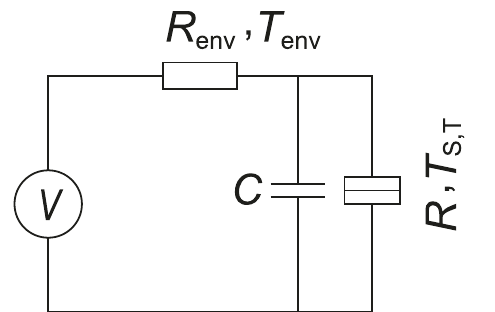
Fig. 2 Lumped element circuit model of the scanning tunneling microscope (STM) junction and its environment. The tunneling junction with tunneling resistance R and temperature T S,T is shunted by the junction capacitance C and connected to a purely dissipative impedance R env whose temperature is T env .